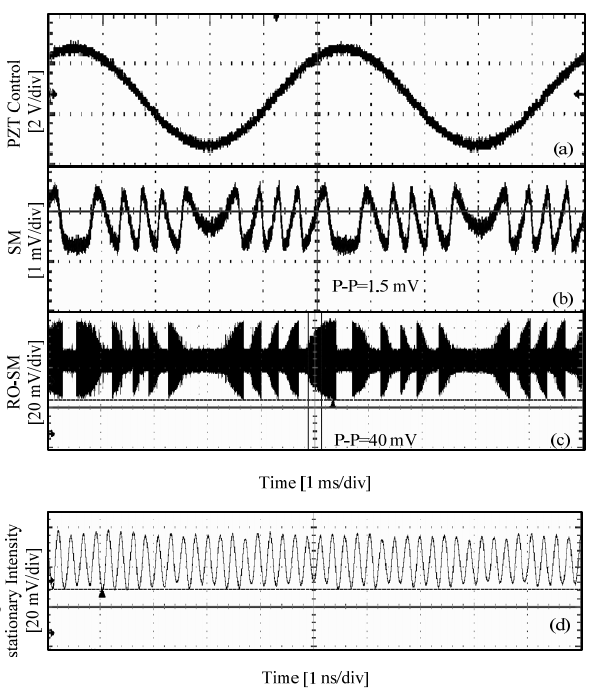
Figure 12. Experimental signals for DL4140-001S. ( a ) PZT control signal; ( b ) conventional SMI signals in steady state; ( c ) SMI signal containing period-one dynamics; ( d ) the laser intensity in the same condition as ( c ) when the target is stationary (adapted from [68]).